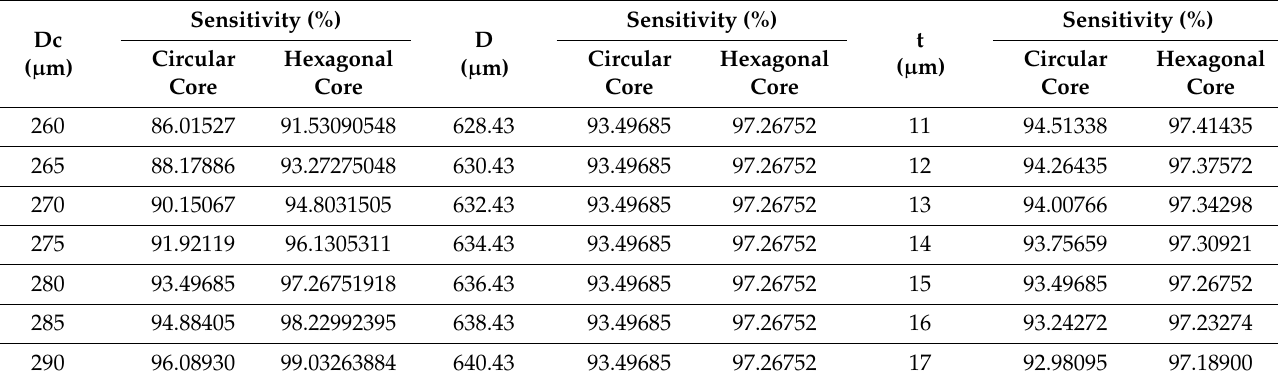
Figure 7. The variation of RS with t of hexagonal and circular core at 2 THz. Table 2. RS of the proposed sensor with the variation of D, D c , and t for 100%